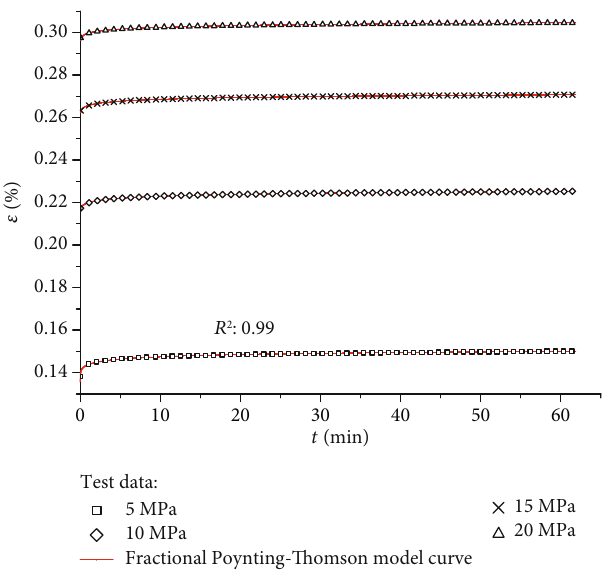
Figure 5: Fractional Poynting-Thomson model.